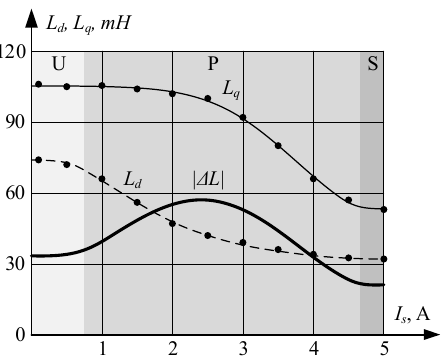
Figure 6. Motor inductances vs. current at the MTPA trajectory.